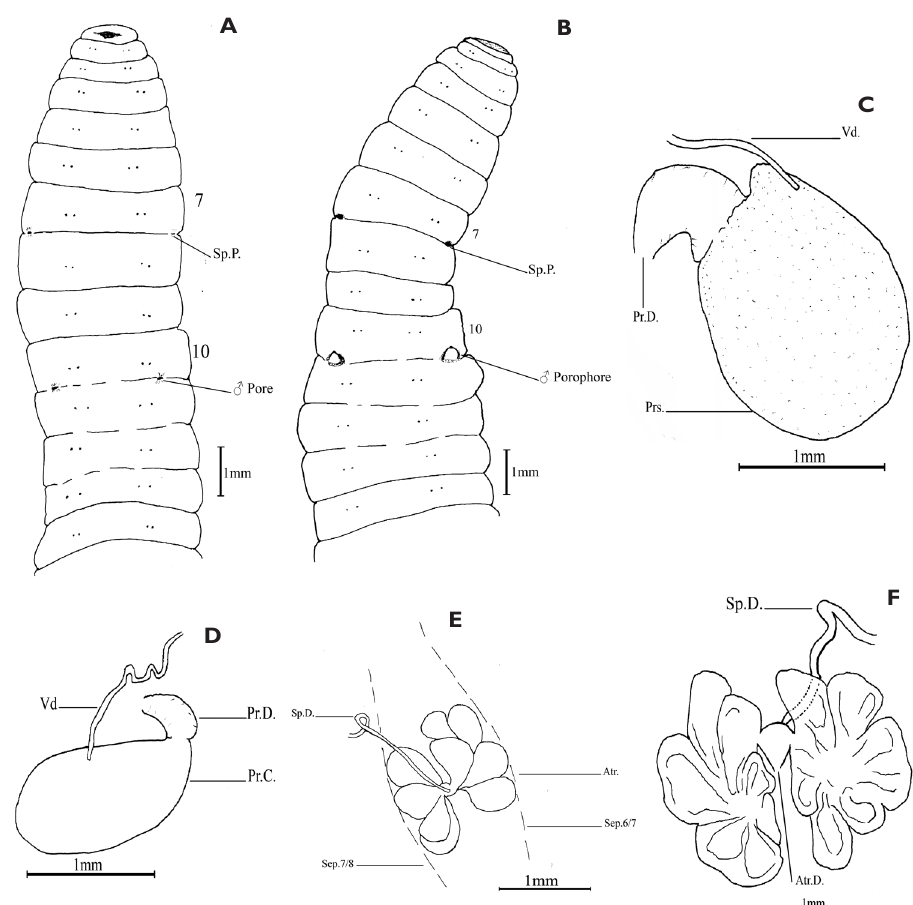
Figure 1. Drawida polydiverticulata sp. n. A Holotype - ventral view B Paratype – ventral view C Pros- tate – ventral view (gland uplifted) D Prostatic capsule – dorsal view E Spermathecal atria - dorsal view F Spermathecal atria - ventral view. Abbreviations: Atr. – Atrium; Atr.D. – Atrial duct; Pr.C. – Prostatic capsule; Prs. – Prostate; Pr.D. – Prostatic duct; Sep. – Septum; Sp.D. – Spermathecal duct; Sp.P. – Sper- mathecal pore; Vd – Vas